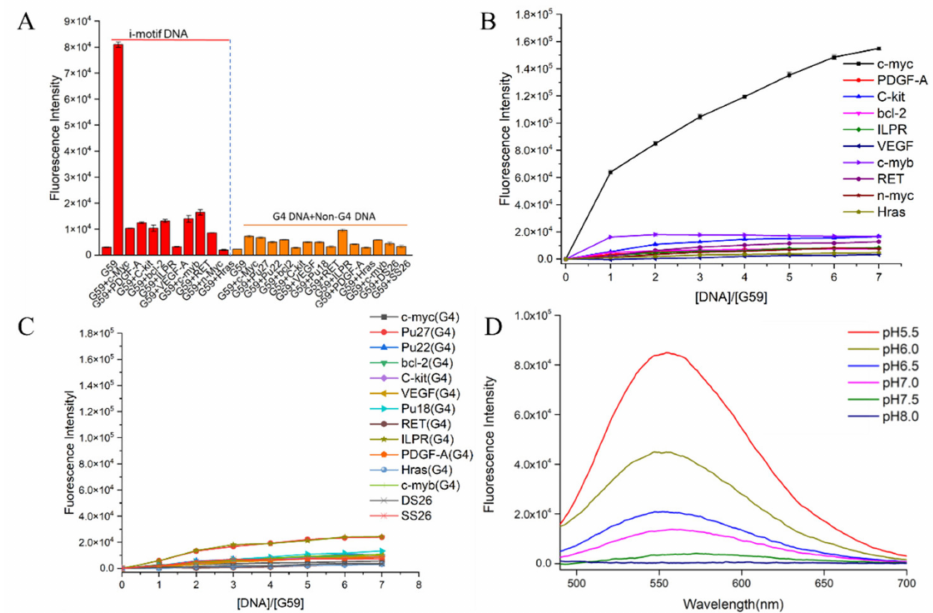
Figure 2. Fluorescent property of G59 upon addition of various DNAs with λ ex of 407 nm. ( A ) Fluo- rescent intensity of 1 µ M G59 with 2 µ M different i-motifs in 1 × BPES buffer at pH 5.5, and 1 µ M G59 with 2 µ M different G-quadruplexes and linear DNAs in 20 mM Tris–HCl buffer containing 100 mM KCl at pH 7.4. ( B ) Fluorescence titration spectra of G59 with various i-motifs in 1 × BPES buffer at pH 5.5. ( C ) Fluorescence titration spectra of G59 with various G-quadruplexes and linear DNAs in 20 mM Tris–HCl buffer containing 100 mM KCl at pH 7.4. ( D ) Fluorescence spectra of 1 µ M G59 with 2 µ M c-myc promoter i-motif at different